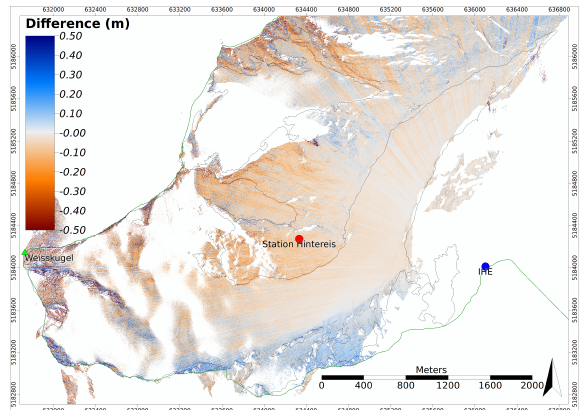
Figure 5. Difference plot of the scans made at 6 November 2020 between 12:11 and 14:06. The differences are given in m. The permanent TLS IHE (blue dot), Station Hintereis (red dot), the mountain top Weißkugel (lime green triangle), the Austrian-Italian border (green) and the borders of HEF according to ALS data of 2017 (black) are also given.